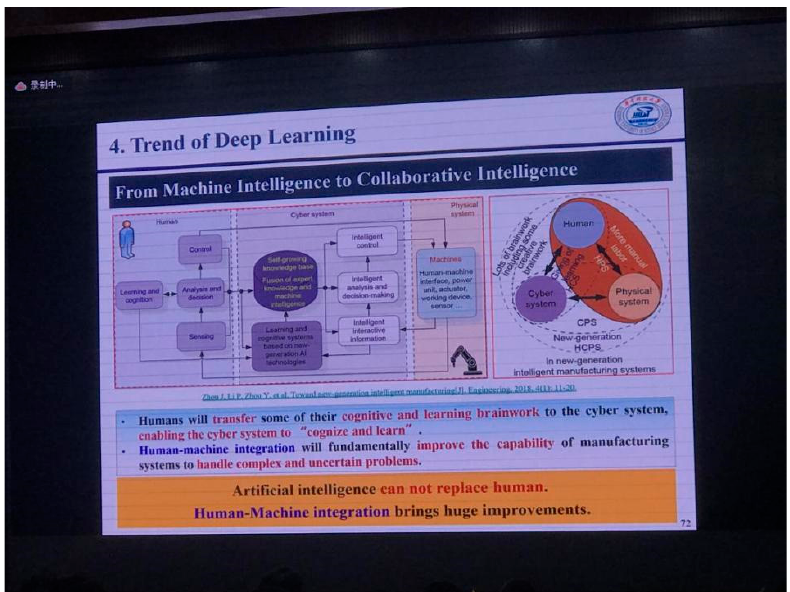
Figure 6. The speech of Professor Gao Liang: Development Trend of Deep Learning.